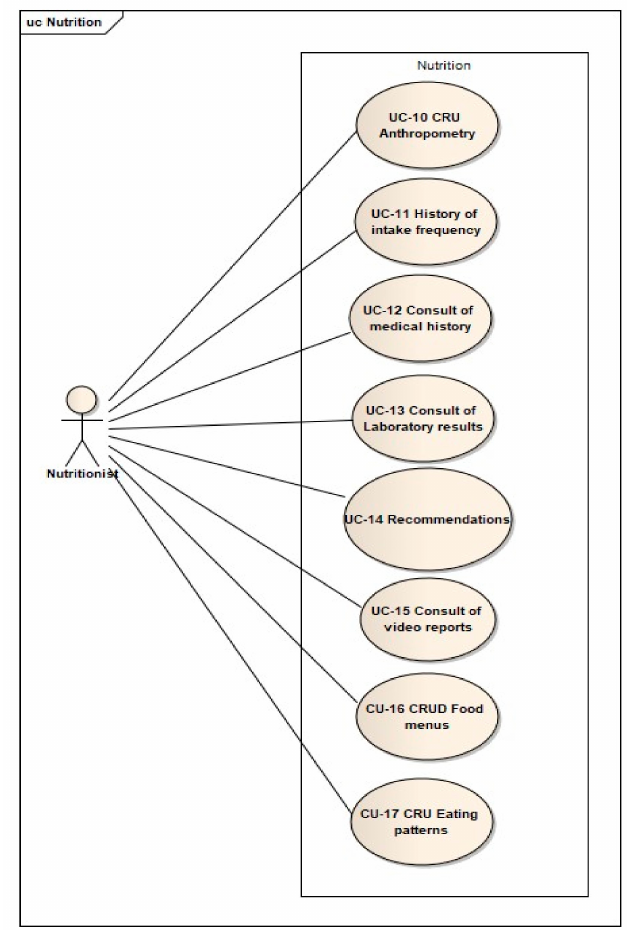
Figure 5. Nutrition UC